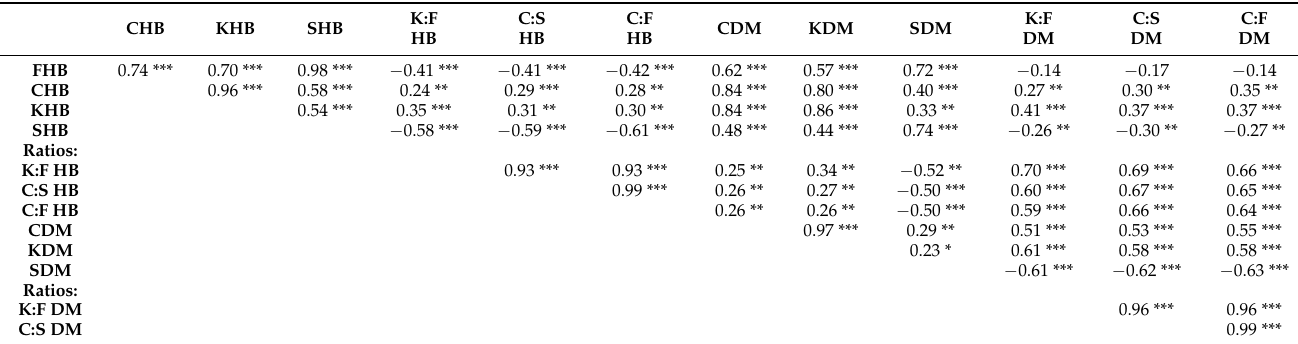
Table 6 shows the individual Pearson’s correlations between the evaluated variables. Almost all correlations were significant ( p < 0.01). All the variables evaluated in HB highly correlated with the DM yields (r > 0.74); similarly, C:F HB, G:F HB, and C:S HB correlated with the C:F, G:F, C:S DM ratios (r > 0.60). However, FHB highly correlated with the CDM and GDM yields (r > 0.57). Neither SHB nor SDM negatively correlated with cobs or grain DM yields (r varied from 0.23 to 0.48). Table 6. Pearson’s correlations between the yield variables evaluated in the humid base (HB) and dry matter